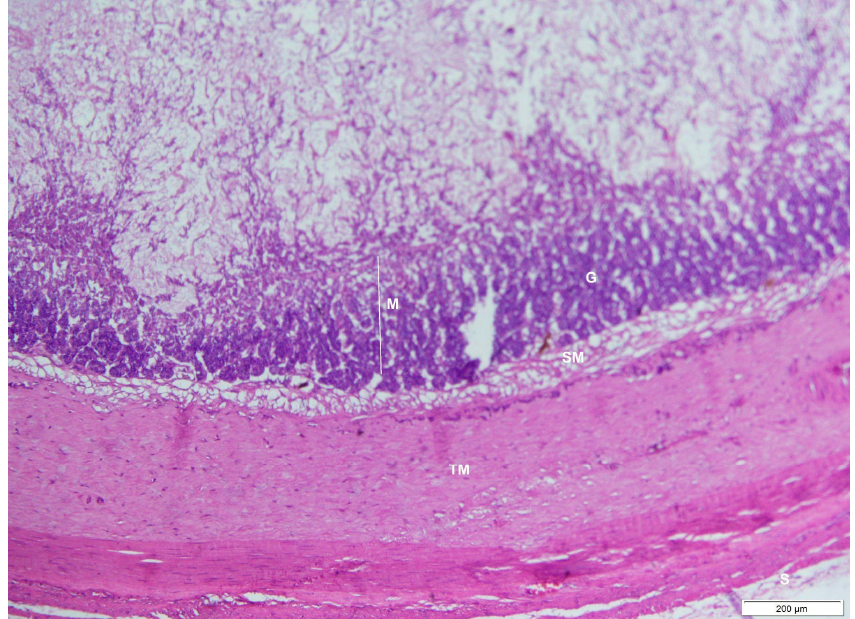
Figure 6. Photomicrograph of a transverse section through the cardiac region of an adult male D. leporina . H&Ex200. M—mucosa; G—gastric glands; SM—submucosa; TM—tunica muscularis; S—serosa.